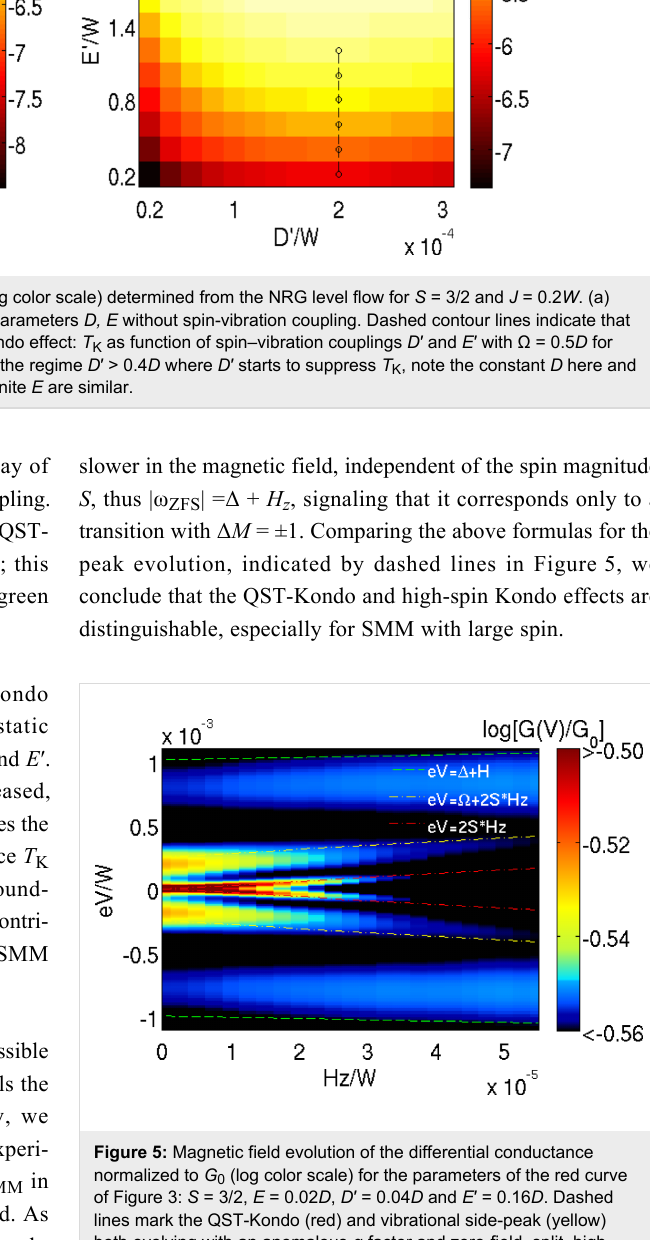
no QST-Kondo effect at zero field, but instead a zero-bias conductance dip (for 0 < E < D ). As pointed out in [24] a